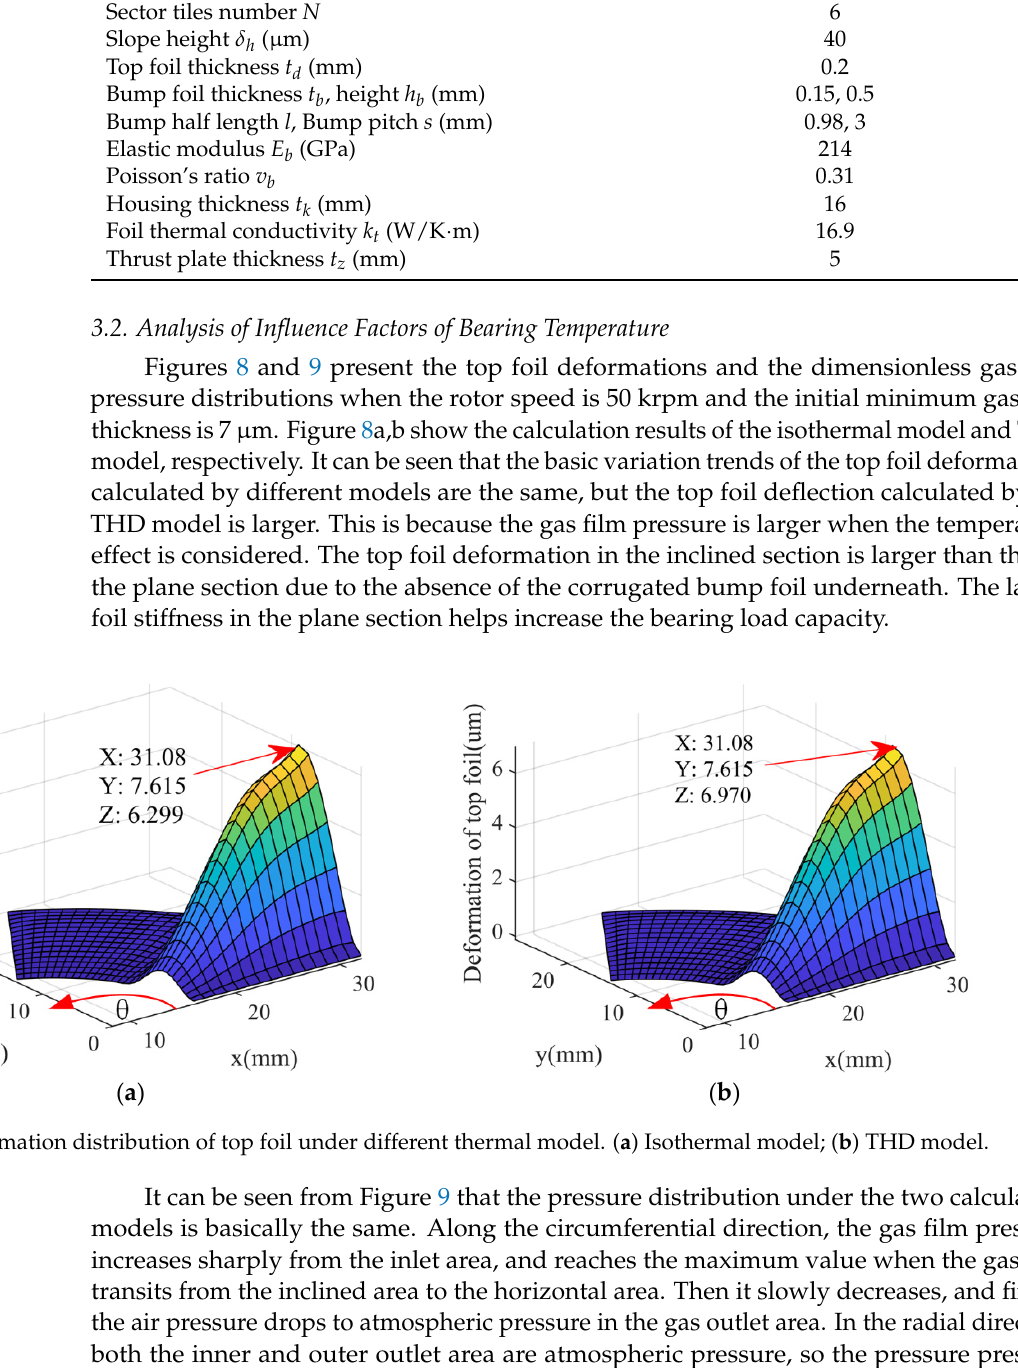
Figure 9. Dimensionless gas film pressure distribution under different thermal model. ( a ) Isothermal model; ( b ) THD model.